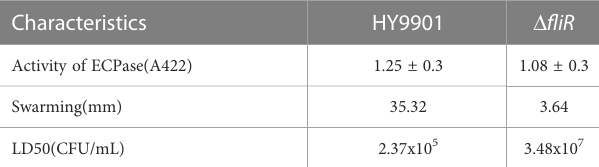
TABLE 3 The biological properties of Vibrio alginolyticus HY9901 compared with the fl iR mutant strain. Characteristics